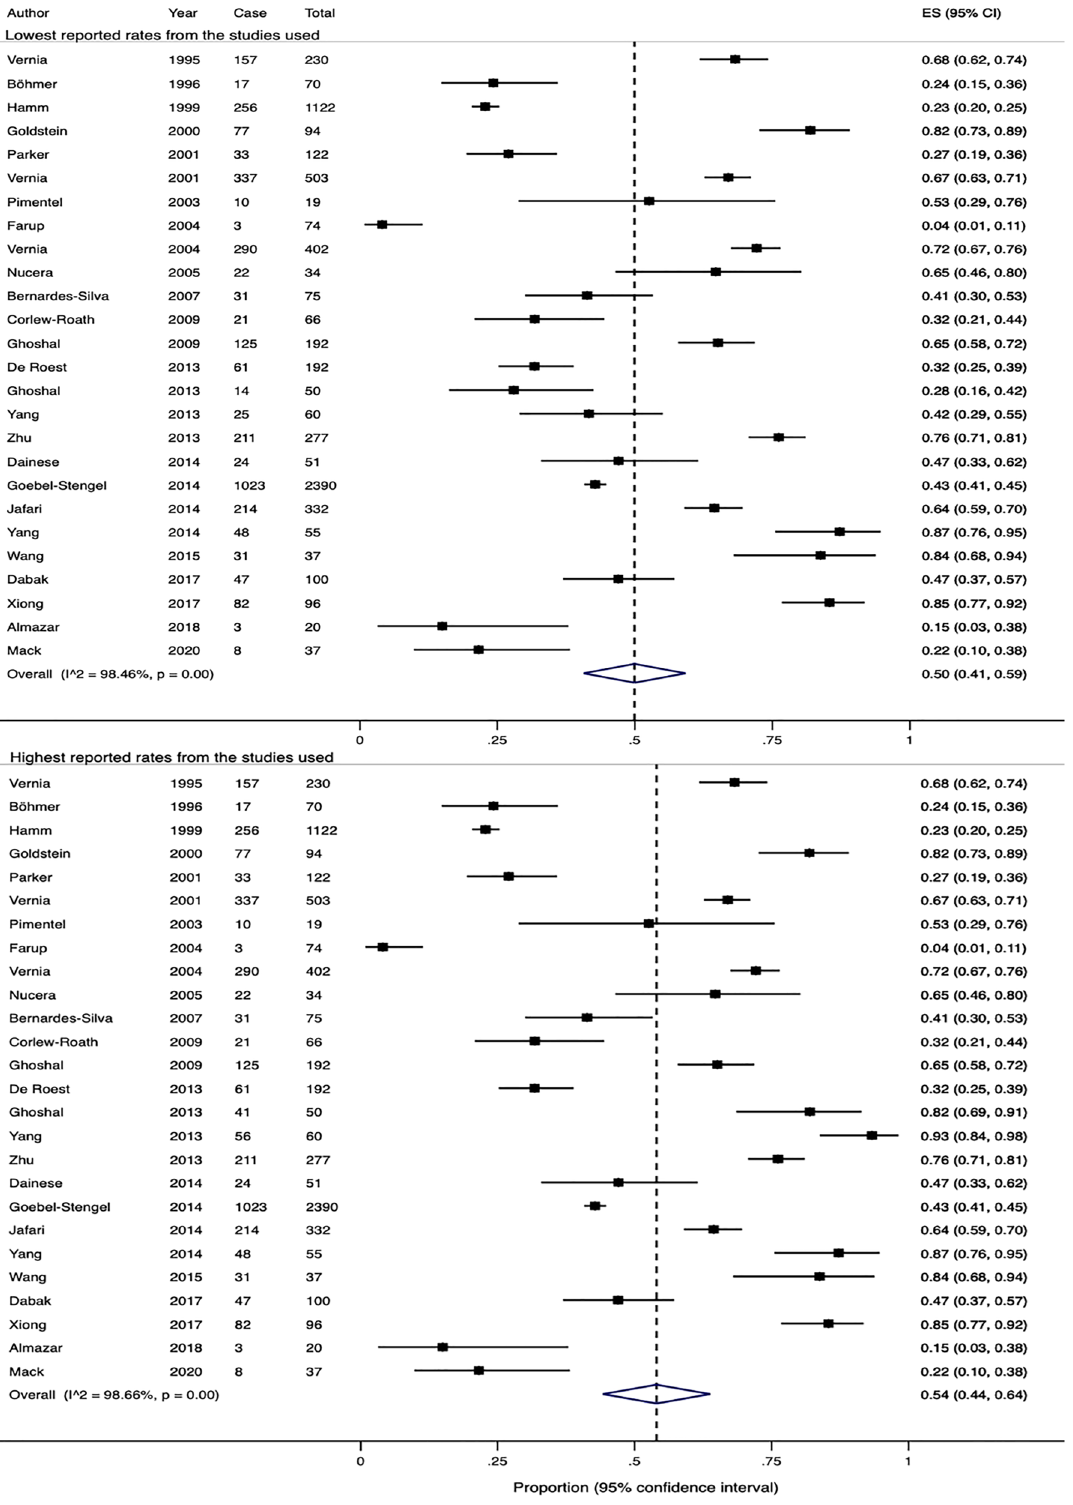
Figure 2. Forest plots showing the estimated pooled prevalence of lactose malabsorption using breath